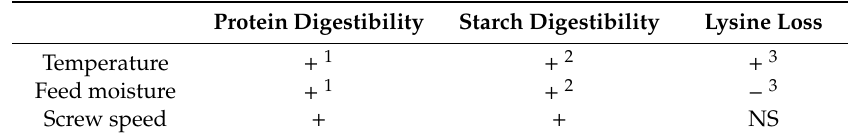
Table 4. E ff ect (positive / negative) of the increase in the main processing parameters of extrusion cooking on the nutritional characteristics of legume-based extruded products. Protein Digestibility Starch